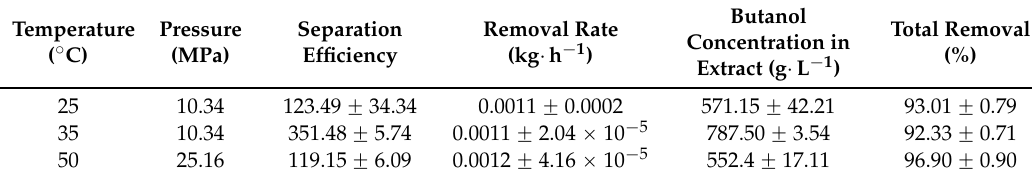
Table 2. Separation efficiency, removal rate (kg ¨ h ´ 1 ), concentration in extract (g ¨ L ´ 1 ) and total removal (%) using liquid CO 2 (25 ˝ C and 10.34 MPa) and supercritical CO 2 (50 ˝ C and 25.16 MPa).